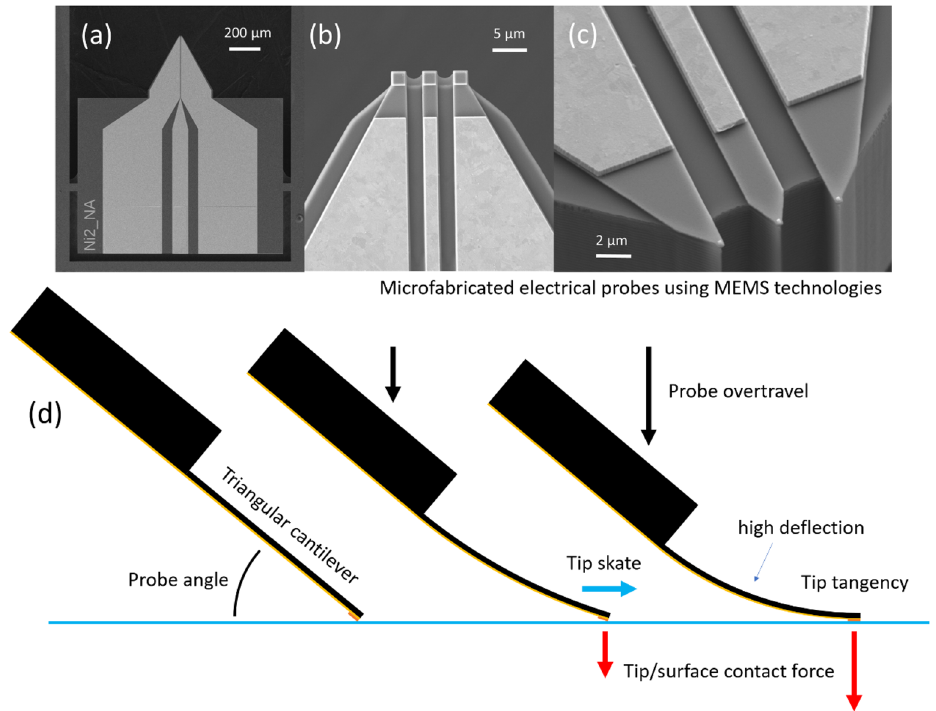
Figure 1. Microfabricated electrical probes using MEMS technologies which incorporate a microcantilever. SEM images showing ( a ) a silicon support chip and protruding ‘chip-edge’ triangular microcantilever, ( b ) and ( c ) zooms on tip showing the contact pads having micrometre (2 µm × 2 µm gold pads) and sub-micrometre size (200 nm × 200 nm gold pads). ( d ) A schematic illustration of how an imposed downward overtravel (black arrows) achieves a necessary contact force (red arrows) for a low resistivity contact but at the expense of a tip skate (blue arrow) across the surface du to bending of the